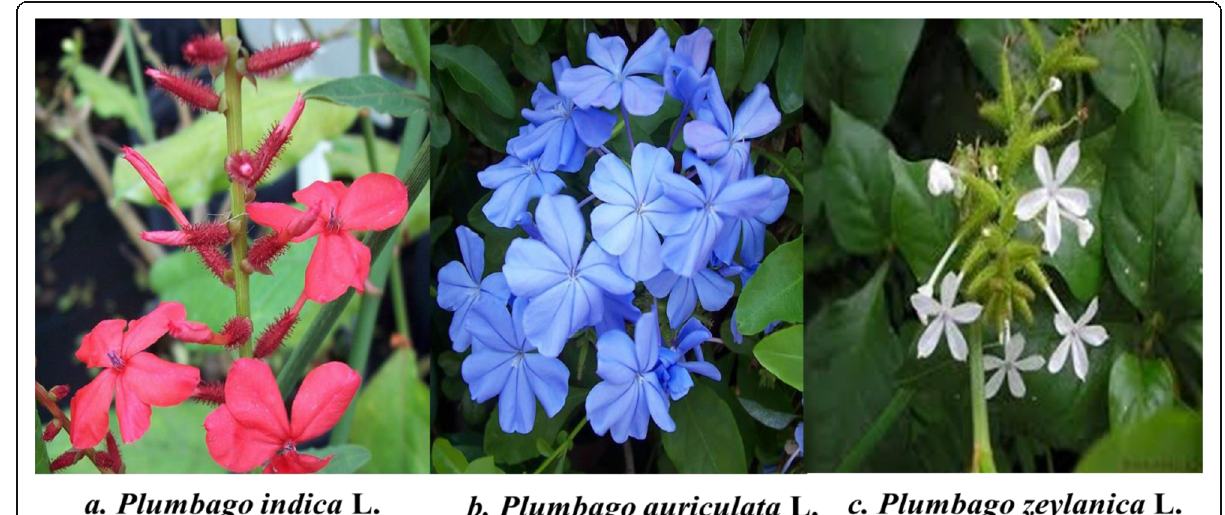
Fig. 1 Genus Plumbago Species